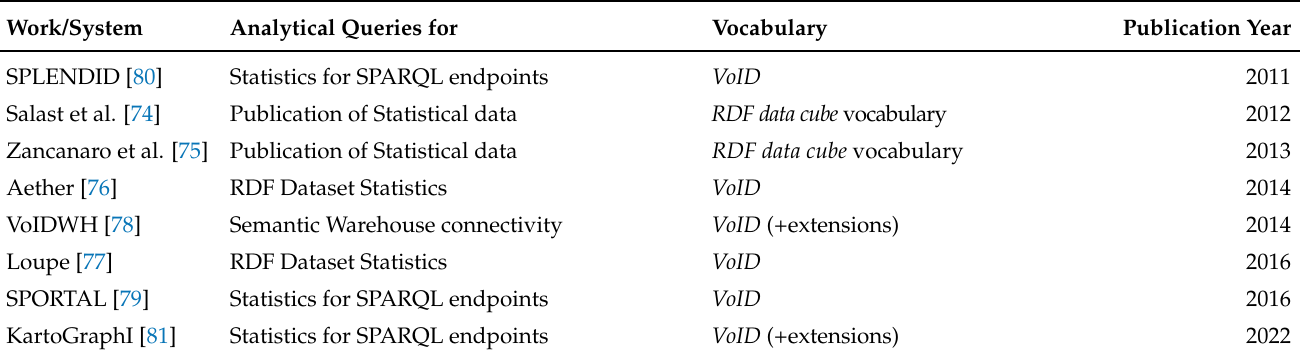
Table 3. Overview of the introduced Works of Category C4 (supporting mainly analytical queries of Category B).